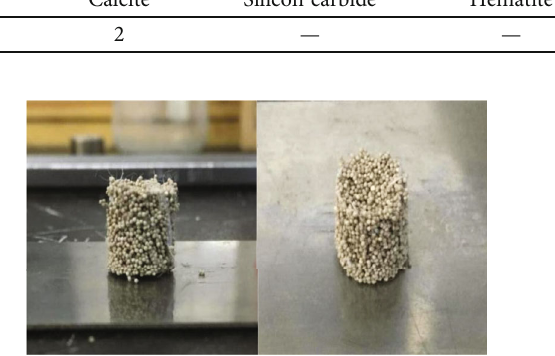
Figure 3: Visual observation of proppant